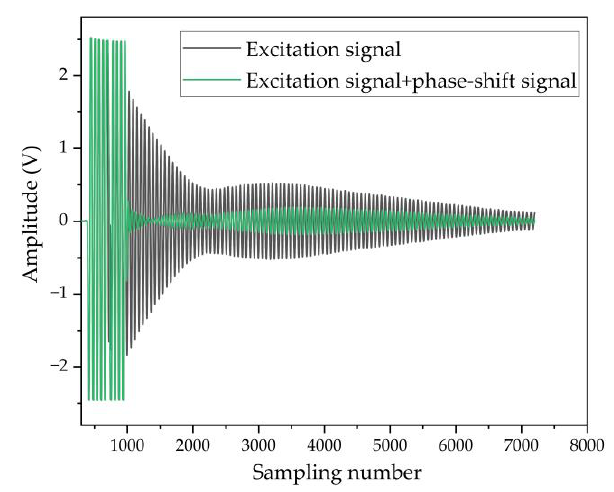
Figure 4. Crosstalk signal at the receiver (black line: there is no phase shift signal at the transmitter; green line: phase shift signal is applied at the transmitter).